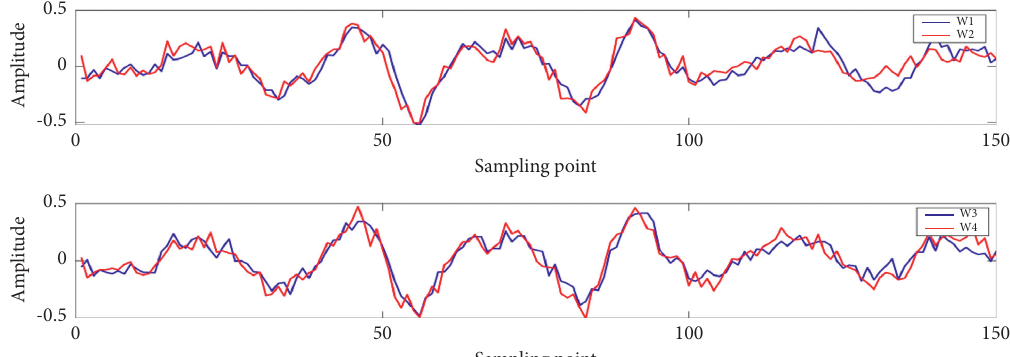
,W ,W , and W are fault components accurately extracted from D opt W 1 2 3 4